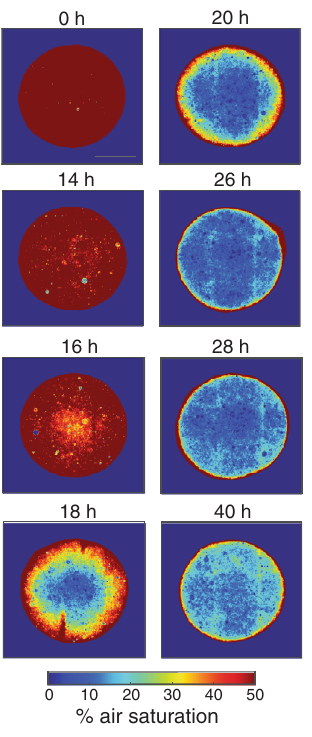
Fig. 4 Evolution of anoxia within particles in partially aerated fl uid. Two- dimensional pro fi les of air saturation were generated from particles co- seeded with the NarK-GFP reporter strain (nitrate reductase) and oxygen nanosensors. Scale bar = 700 μ m. Separate analogous particles with the NirS-dsRed reporter strain (nitrite reductase) were incubated in parallel (Supplementary Fig. 7). For both, suboxic conditions develop in the particle core and then migrate outward toward the particle periphery over